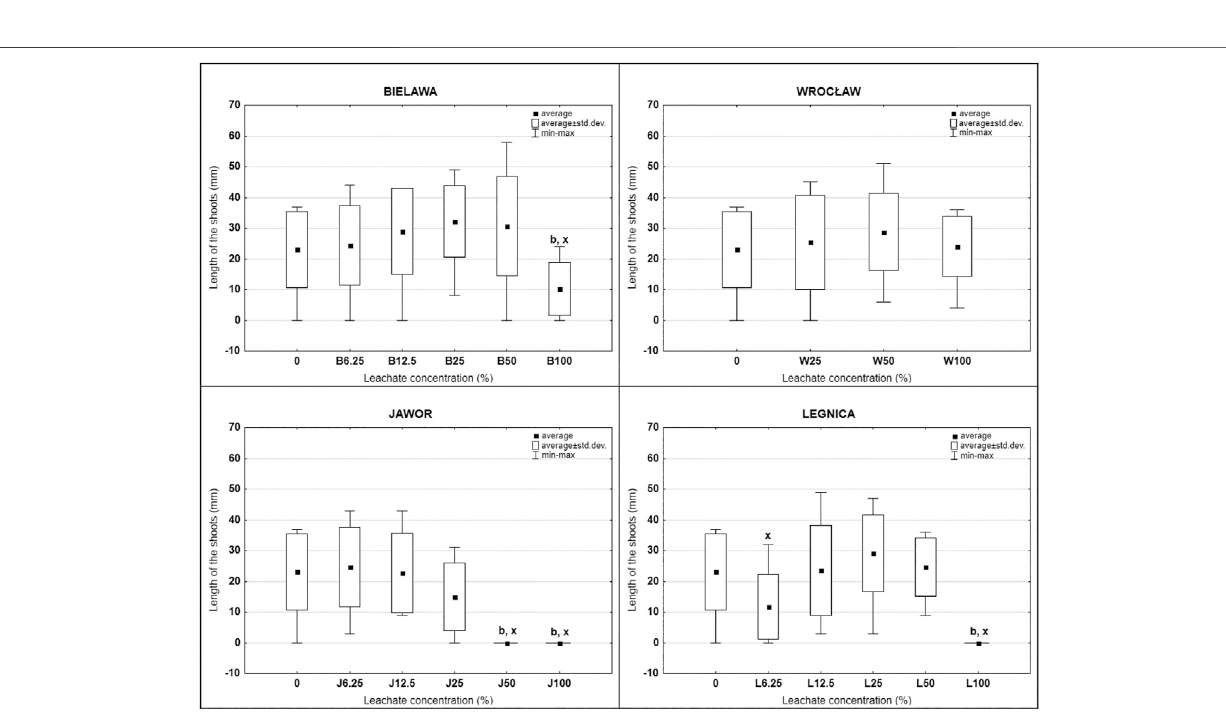
Frontiers in Environmental Science |